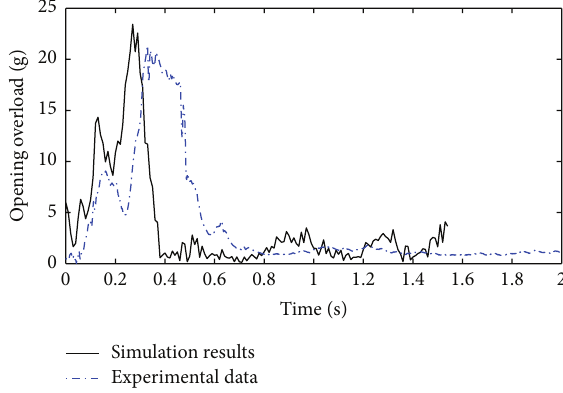
Figure 7: Drag force versus time (numerical and experimental).